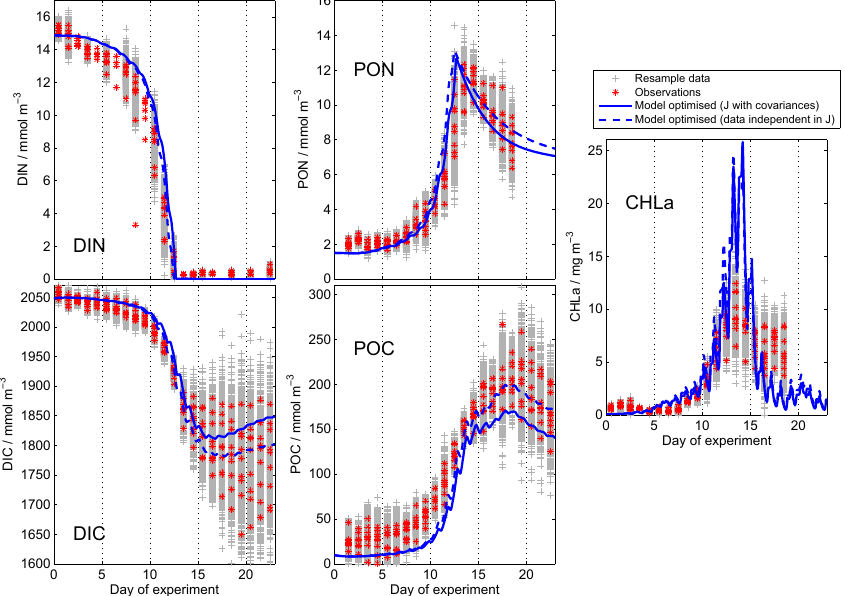
Figure B1. Observations of nine mesocosms (red asterisks), resampled data (grey markers), and optimized simulation results (blue lines): dissolved inorganic nitrogen and carbon (DIN and DIC), particulate nitrogen and carbon (PON and POC), and chlorophyll a concentra- tion